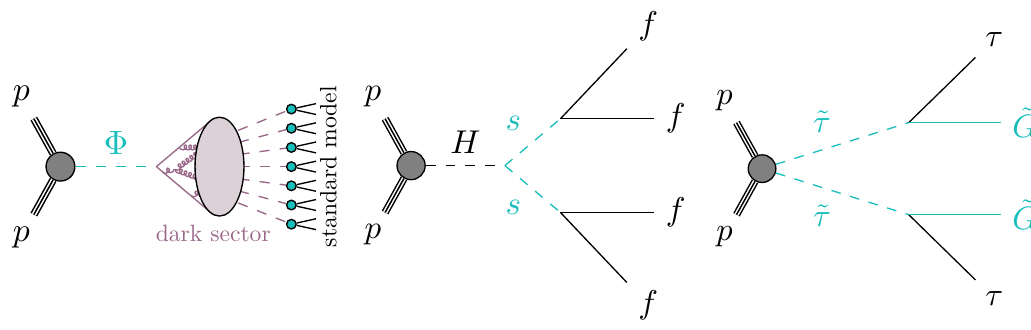
Figure 1. Feynman diagrams for benchmark processes. From left to right: SUEPs, Higgs portal, and long-lived